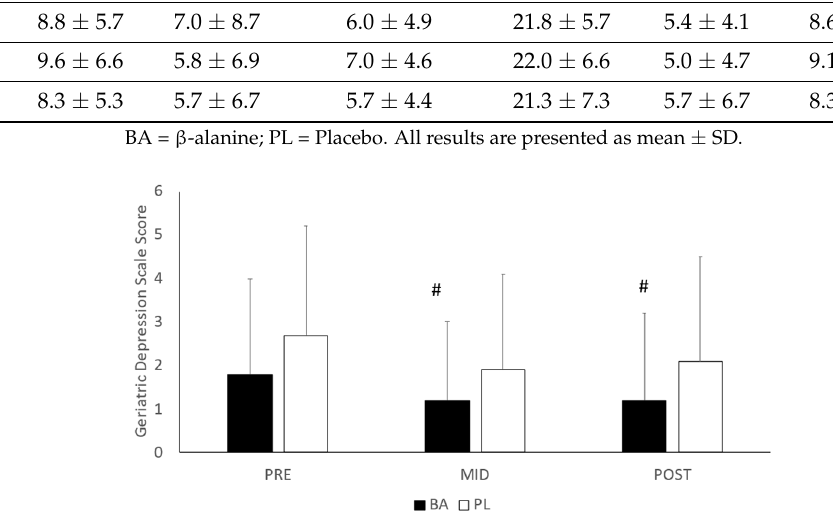
Figure 4. Geriatric Depression Scale. BA = β -alanine; PL = Placebo; # = Significantly different from PRE. All results are presented as mean ± SD.